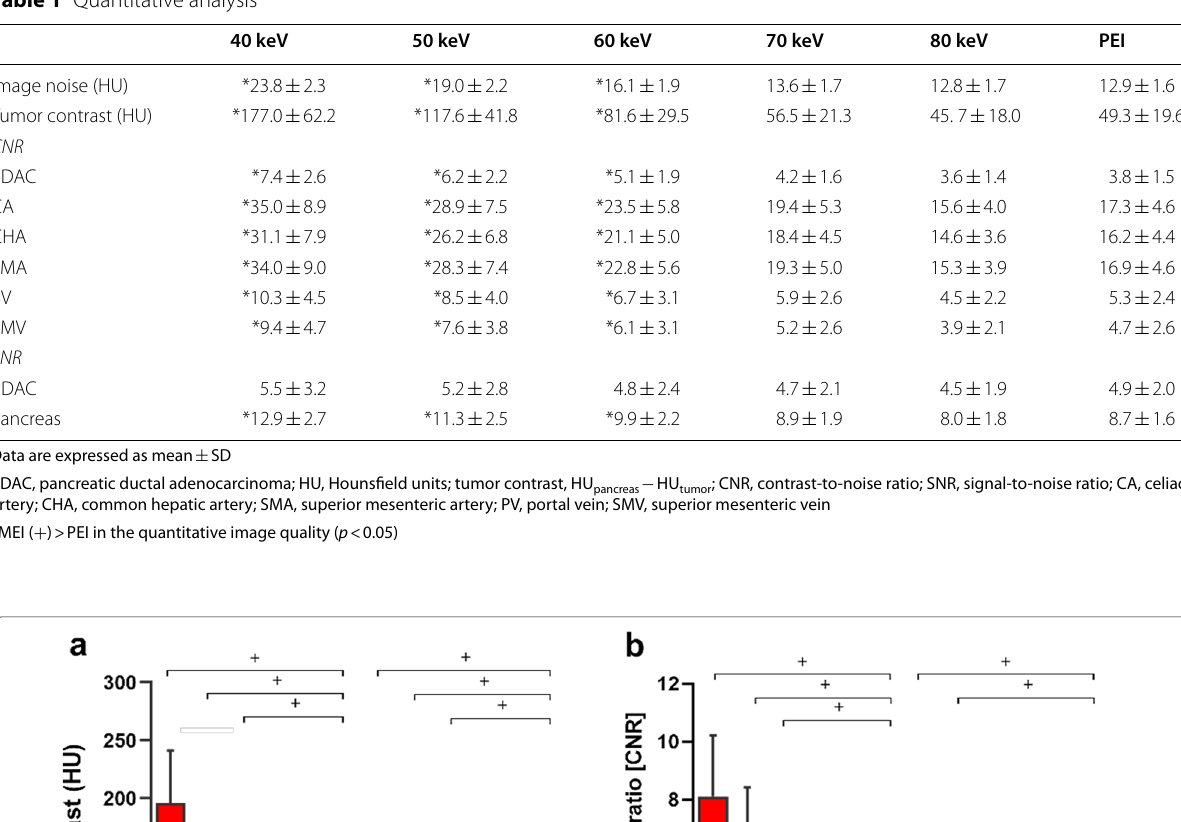
Table 1 Quantitative analysis